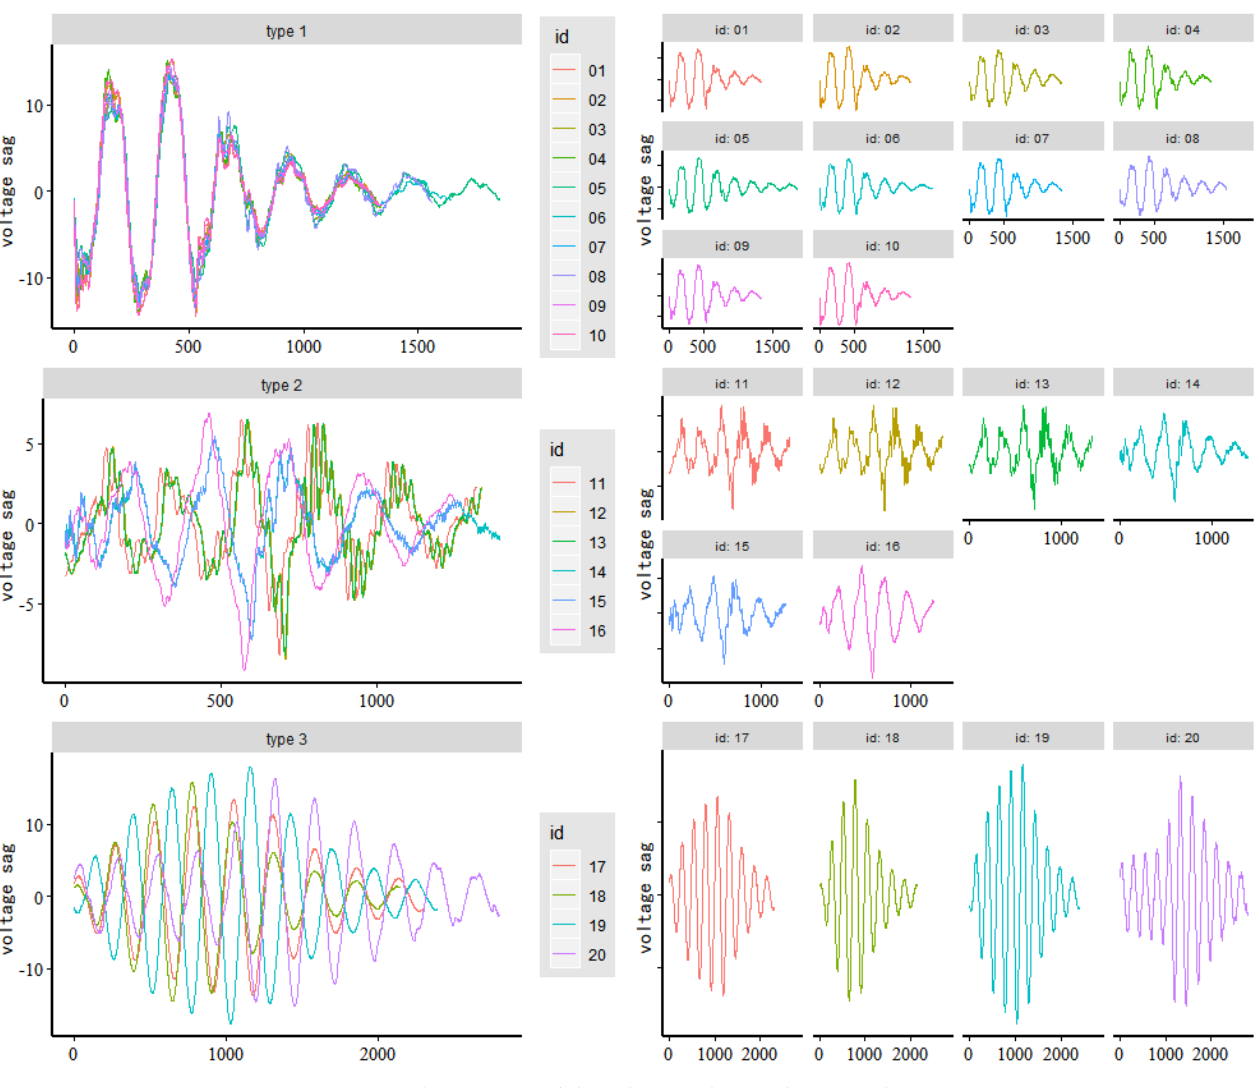
Figure 11. Clustering result based on A-phase voltage sag